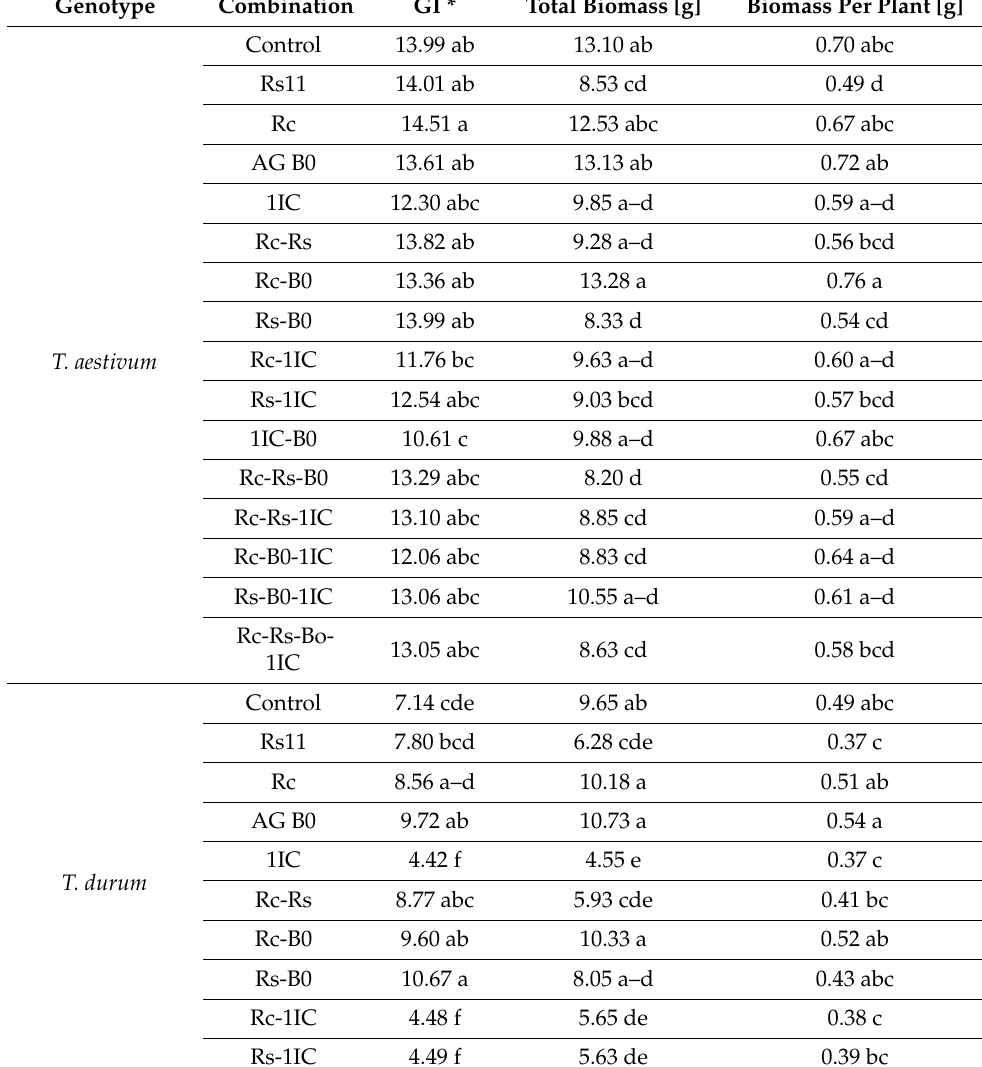
Table 1. One-way Anova results for each plant genotype’s basic biometric parameters including the germination index (GI) in experimental combinations. Different letters (a to g) indicates a statistical different group as determined by the mean value of the